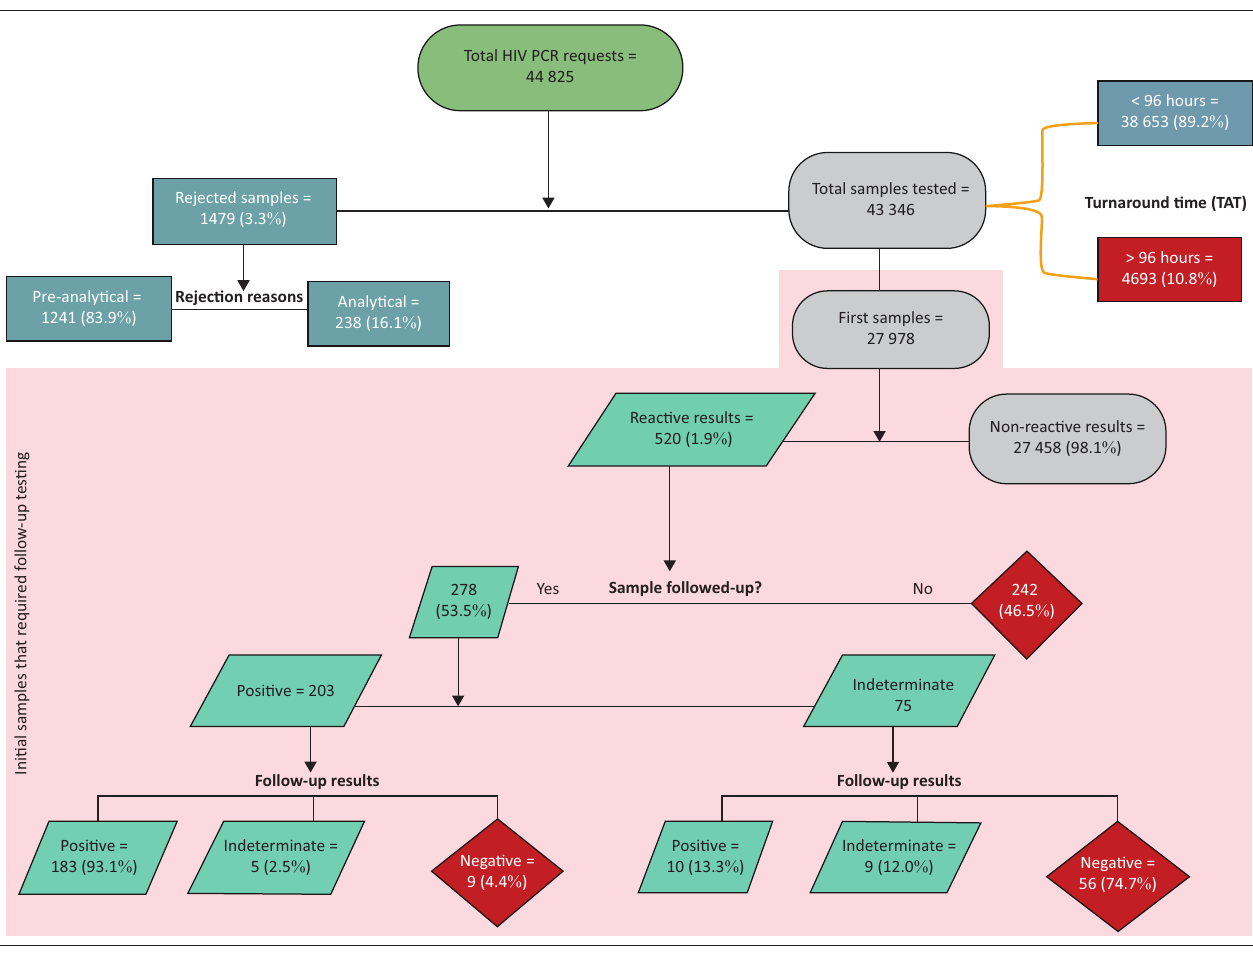
FIGURE 2: Numbers of HIV PCR requests, rejected samples, and follow-up tests conducted at Tygerberg Hospital, Cape Town, South Africa, between July 2017 and June 2019.